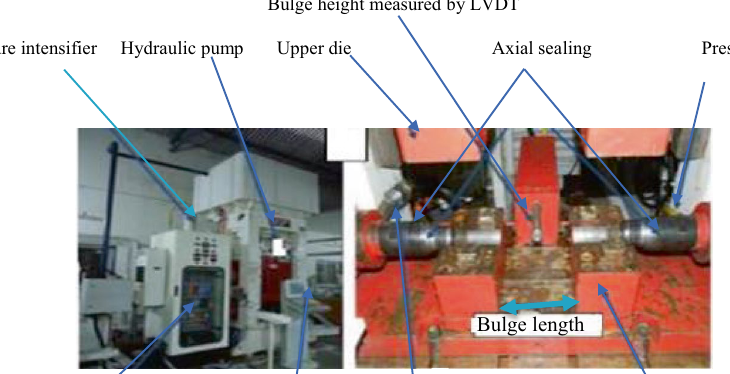
Fig. 7 Experimental setup